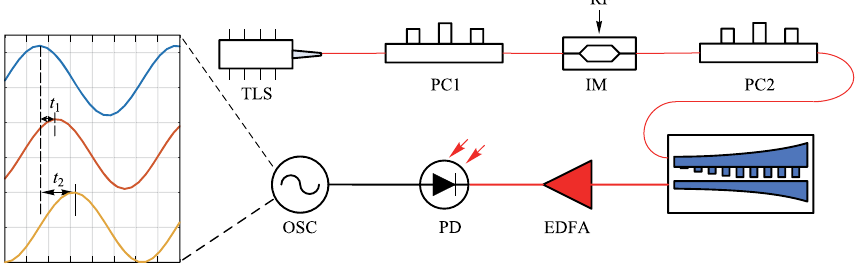
Fig. 5 Measurement setup for group delay. TLS tunable laser source, PC polarization controller, RF radio frequency source, IM intensity modu- lator, EDFA erbium doped fiber amplifier, PD photodetector, OSC